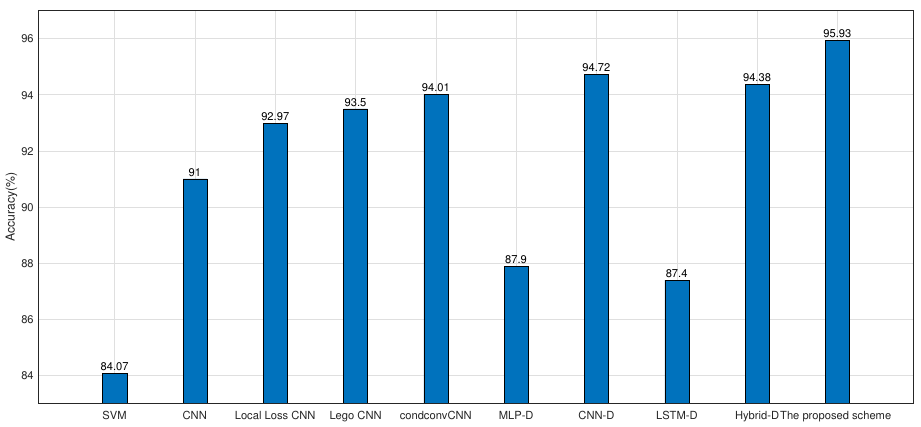
Figure 15. The comparison of accuracy using different methods in the PAMAP2 data set. Table 7. The comparison of evaluation indicators using different methods in the PAMAP2 data set.